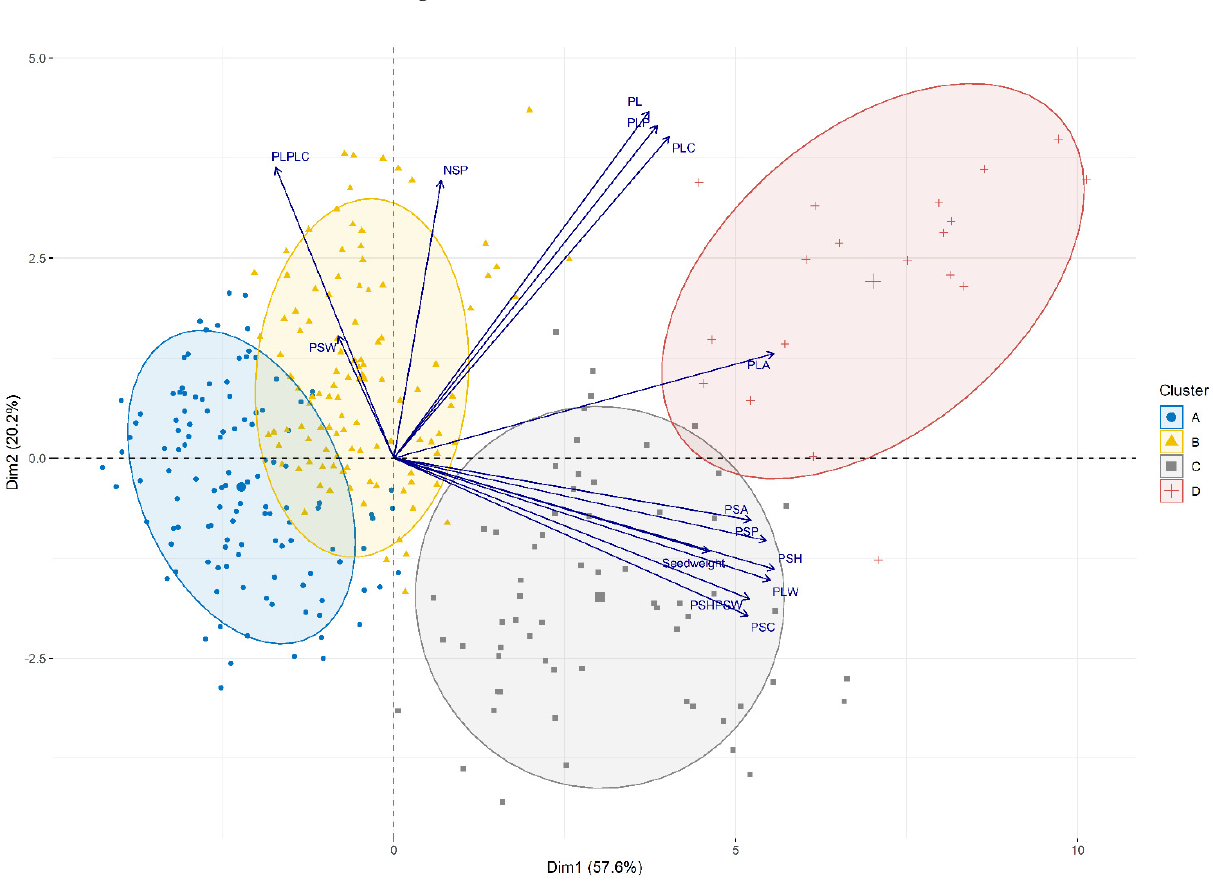
Figure 1. Biplots showing the results of the Hierarchical Clustering on Principal Components analysis from 14 evaluated quantitative pod traits (PLP, PLA, PLW, PL, PLC, PL/PLC, PSP, PSA, PSW, PSH, PSH/PSW, PSC, NSP, Seed weigh; see Table S2) in the Snap Bean Panel. Ellipses representing the clusters were drawn considering a confidence interval > 0.8.